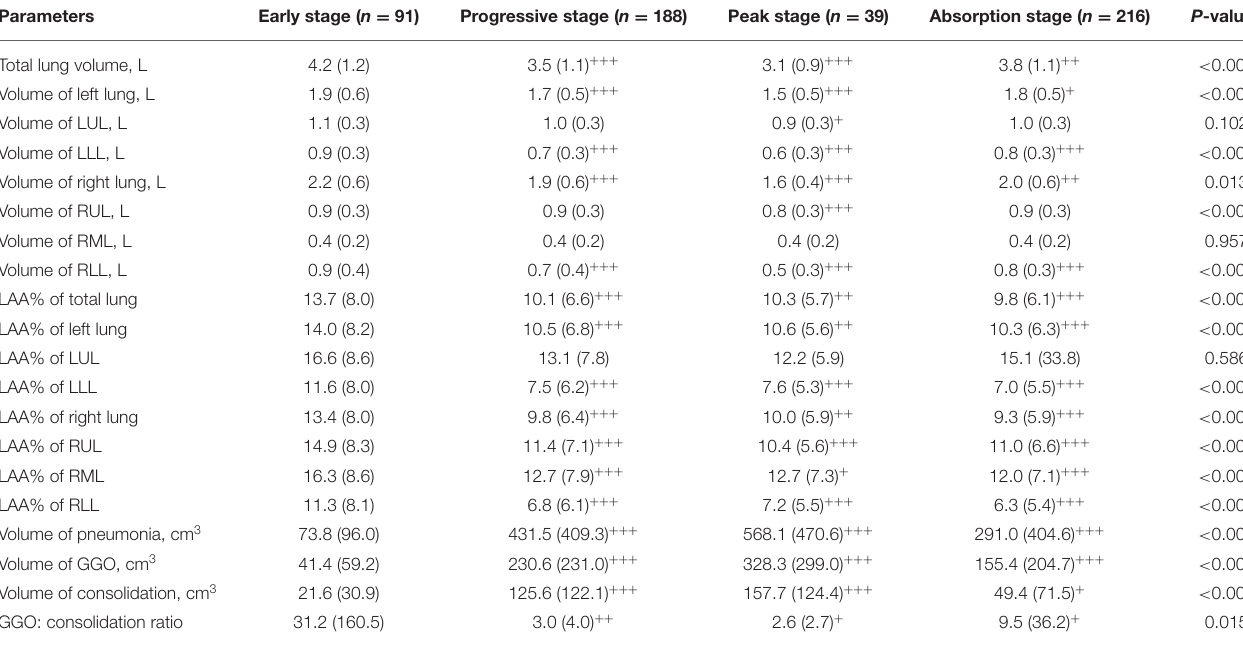
TABLE 1 | Comparison of lung and pneumonia parameters generated by the CAD system among the four stages. Parameters